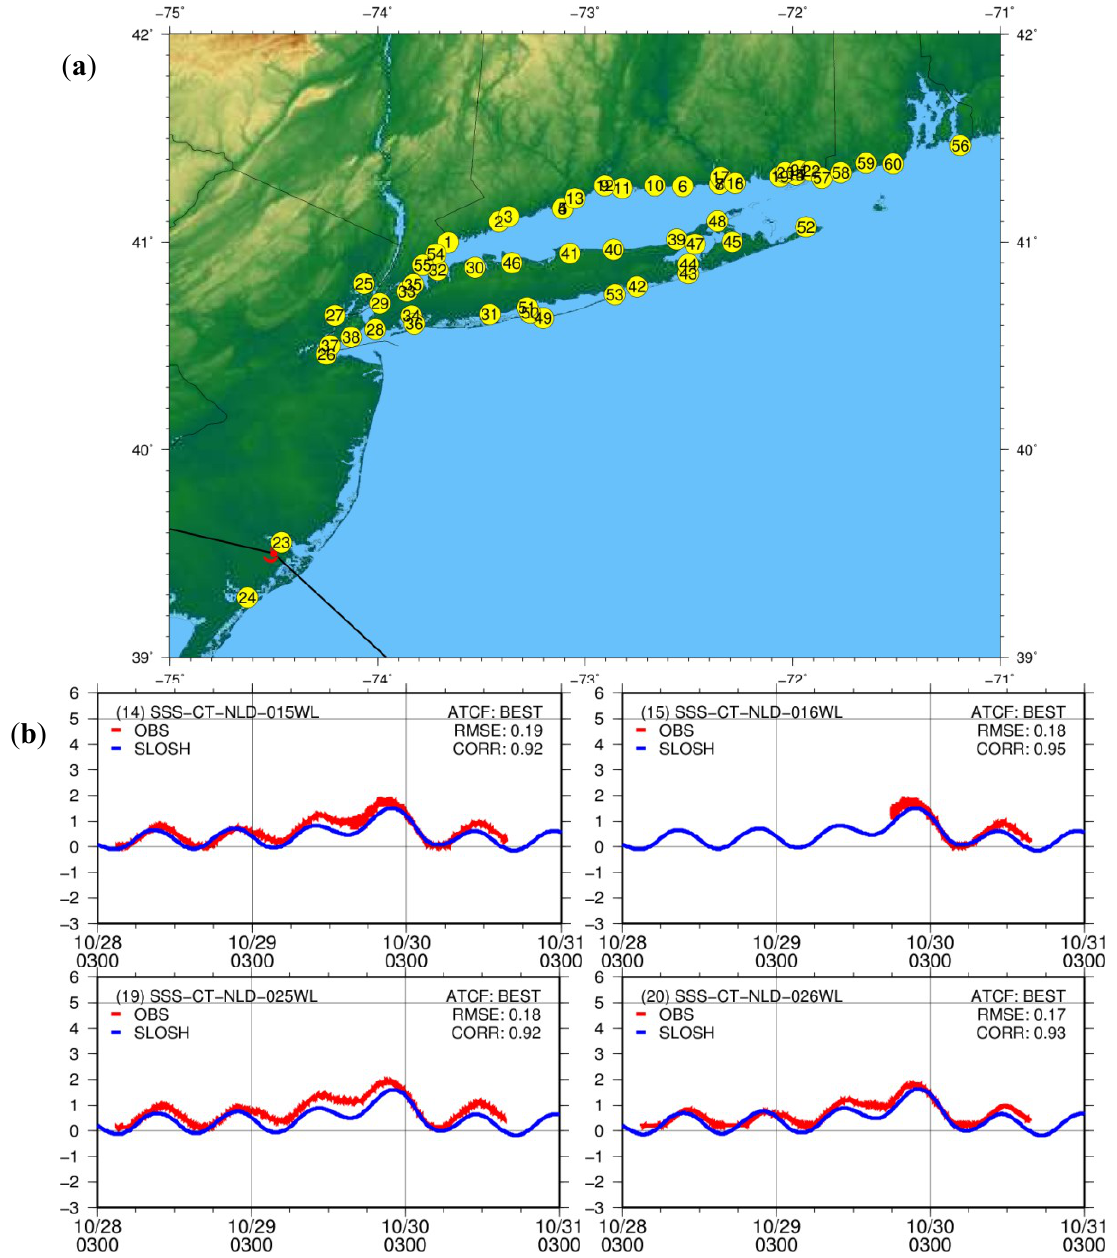
Figure 13. ( a ) Map of USGS Storm Surge Sensor (SSS) locations; ( b ) Hydrographs of inundation recorded by USGS SSS ( red ) vs. SLOSH-simulated surge-plus-tides water levels above ground level (AGL) ( blue ) with RMS error and correlation calculated between the two types of time series. Time is in month/day and hours UTC (horizontal axis) and water elevations are in meters (vertical axis). The sensor numbers in the time series plots in ( b ) correspond to the locations shown in panel ( a